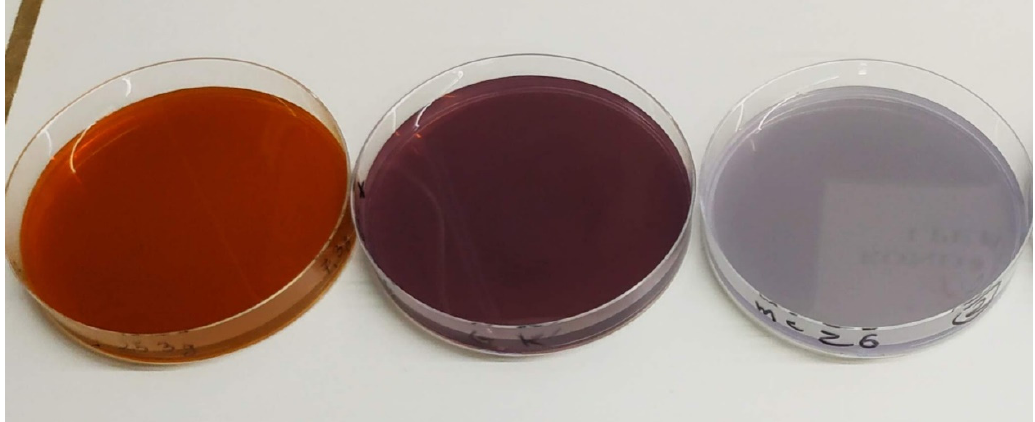
Figure 1. Obtained foils: from the left 1. Ag-xylose; 2. Ag-maltose; 3. Ag-glucose.